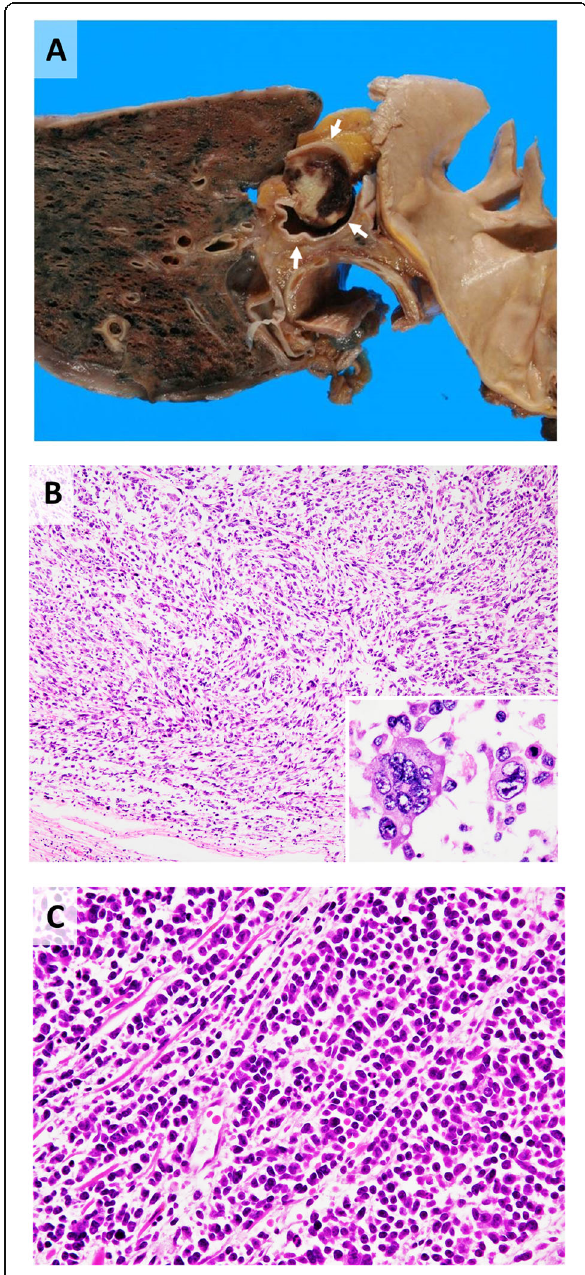
Fig. 5 Relapsed cytokeratin-positive interstitial reticulum cell (CIRC) tumor and small cell carcinoma at autopsy. a Macroscopic findings of the CIRC tumor invading into the superior vena cava (arrow). b Microscopic findings of the CIRC tumor composed of spindle- shaped cells with a loose flow. Inset : high-magnification view of atypical multinucleated cells. c Small cell carcinoma showing typical histological findings on autopsy. Tumor cells had a high N/ C ratio and formed focal molding structures. This finding was completely different from that of CIRC